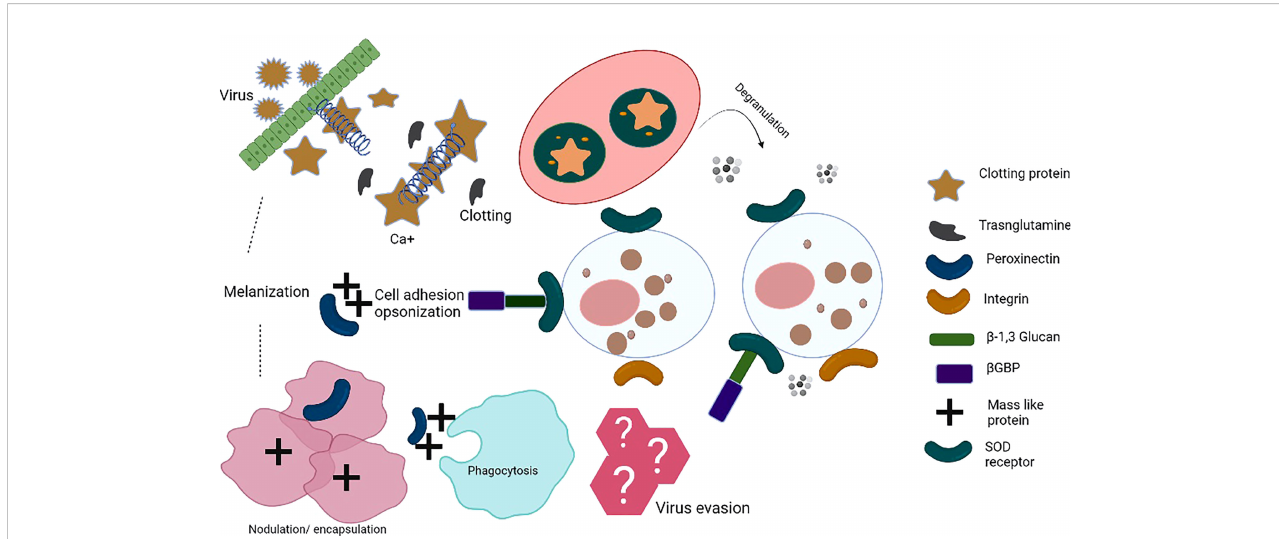
FIGURE 1 Insect innate immune mechanisms: When the insect ’ s immune system recognizes pathogen-associated molecular patterns (PAMPs) by pattern- recognition receptors (PRRs), pathogens encounter a complex system of humoral and cellular responses. Humoral responses include the production of antimicrobial peptides (AMPs), reactive nitrogen intermediates (RNI) or reactive oxygen intermediates (ROI), and a complex enzymatic cascade to regulate clotting or melanization. Cellular immune response involves various haemocytes that participate in phagocytosis/nodulation/encapsulation for pathogen clearance from haemolymph. In addition, different immune cells release toxic factors to kill pathogens, i.e. cell-mediated killing (complement components, etc.). These events take place in the haemocoel of the ticks. The series of immune reactions depict innate immunity. Clotting protein is a unique lipoprotein. Hemolymph clotting is induced upon transglutaminase (TGase) release from hemocytes/tissues. Calcium ions play an important role in the cascade leading to coagulation. TGase is involved in the coagulation, disturbing the chemical nature of the target pathogens. Peroxinectin is an opsonin that does attachment, spreads, and induces degranulation. SOD produces H 2 O 2 from which hypohalic acid is released, which is a toxic substance, Prophenoloxidase activating system (proPO system) is an ef fi cient part of the innate immune response. bGBP is a pattern recognition protein known to bind b -1,3, glucan. Masquerade (Mas-) like protein is also a multifunctional innate immune protein, an opsonin-like peroxinectin, capable of doing pathogen binding, inducing degranulation, and pathogen clearance. TGase, transglutaminase; Ca 2+ , Calcium, SOD, superoxide dismutase; b GBP, glucan with b -1,3 glucan binding protein; Mas-like protein, – Masquerade- like